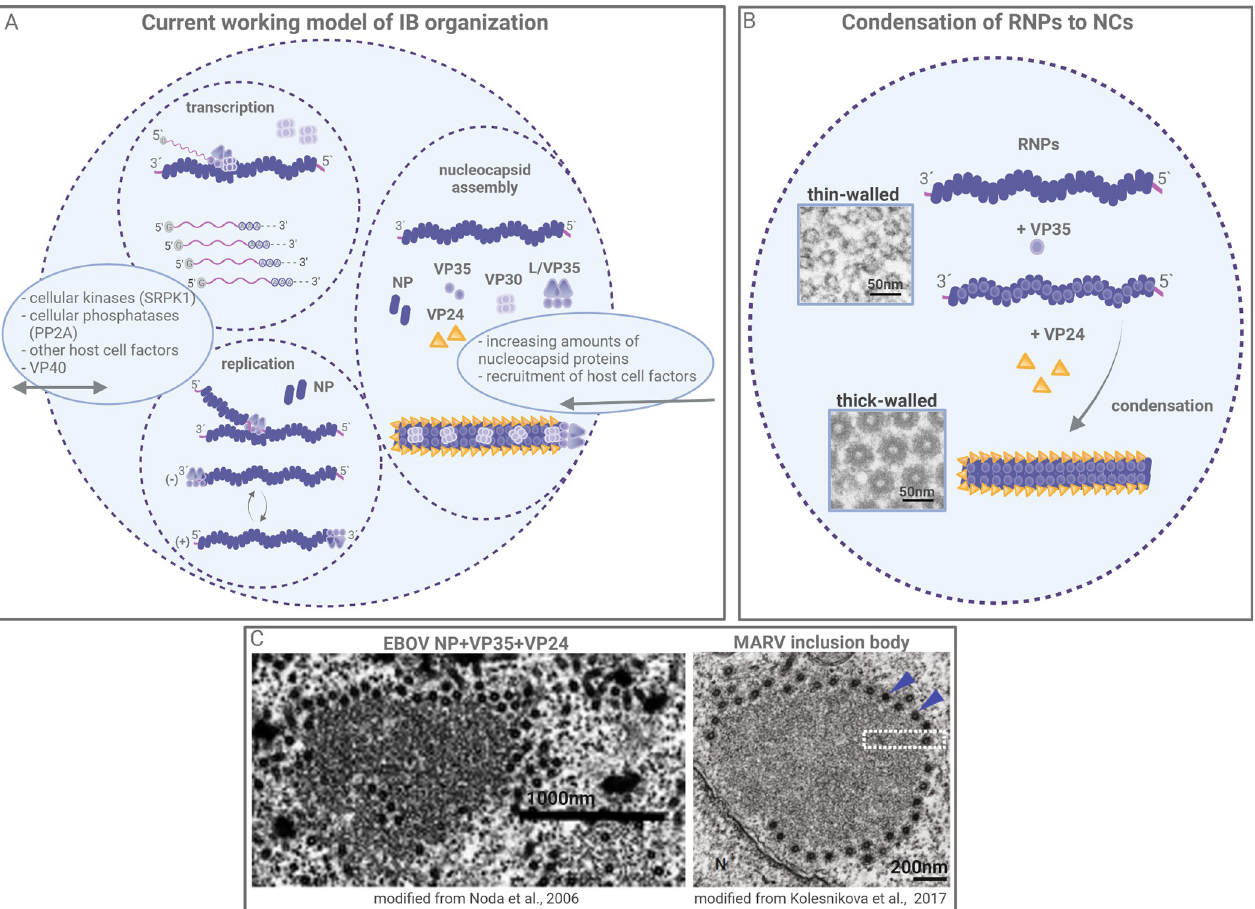
Fig 3. Filovirus inclusion bodies. ( A ) Current working model of IB organization. Transcription and genome replication occur inside IBs. It is possible that the 2 activities are separated in different subcompartments which, however, remains to be investigated. Possible subcompartmentalization of IBs might result from liquid–liquid phase separation based on RNA and protein concentrations. Regulation of viral transcription is partially based on the phosphorylation status of VP30, which modulates interactions with the polymerase cofactor VP35 and the polymerase L. VP30 phosphorylation is regulated by host cell kinases and phosphatases whose localization and availability might be interdependent. Increasing levels of NC proteins and possibly the recruitment of VP40 and/or host cell factors into IBs is thought to trigger the assembly of NCs. ( B ) Model of RNPs condensation to NCs in IBs. Electron micrographs from Noda and colleagues [20] show thin-walled helices upon NP expression and thick-walled helices upon coexpression of NP+VP35+VP24. The thin-walled helices detected inside IBs may represent RNPs that are active in transcription or replication or may represent intermediates of assembly. ( C ) Left picture: Electron micrograph from Noda and colleagues [20] of an IB (left) upon coexpression of EBOV NP, VP35, and VP24 showing cross-sectioned NCLS. Right picture: Electron micrograph from Kolesnikova and colleagues [14] of an IB from a MARV-infected cell with cross-sectioned NCs. Blue arrowheads indicate condensed thick-walled NCs at the periphery of the IB. Figure was created with BioRender.com. IB, inclusion body; NC, nucleocapsid; NCLS, NC-like structure; RNP, ribonucleoprotein complex.